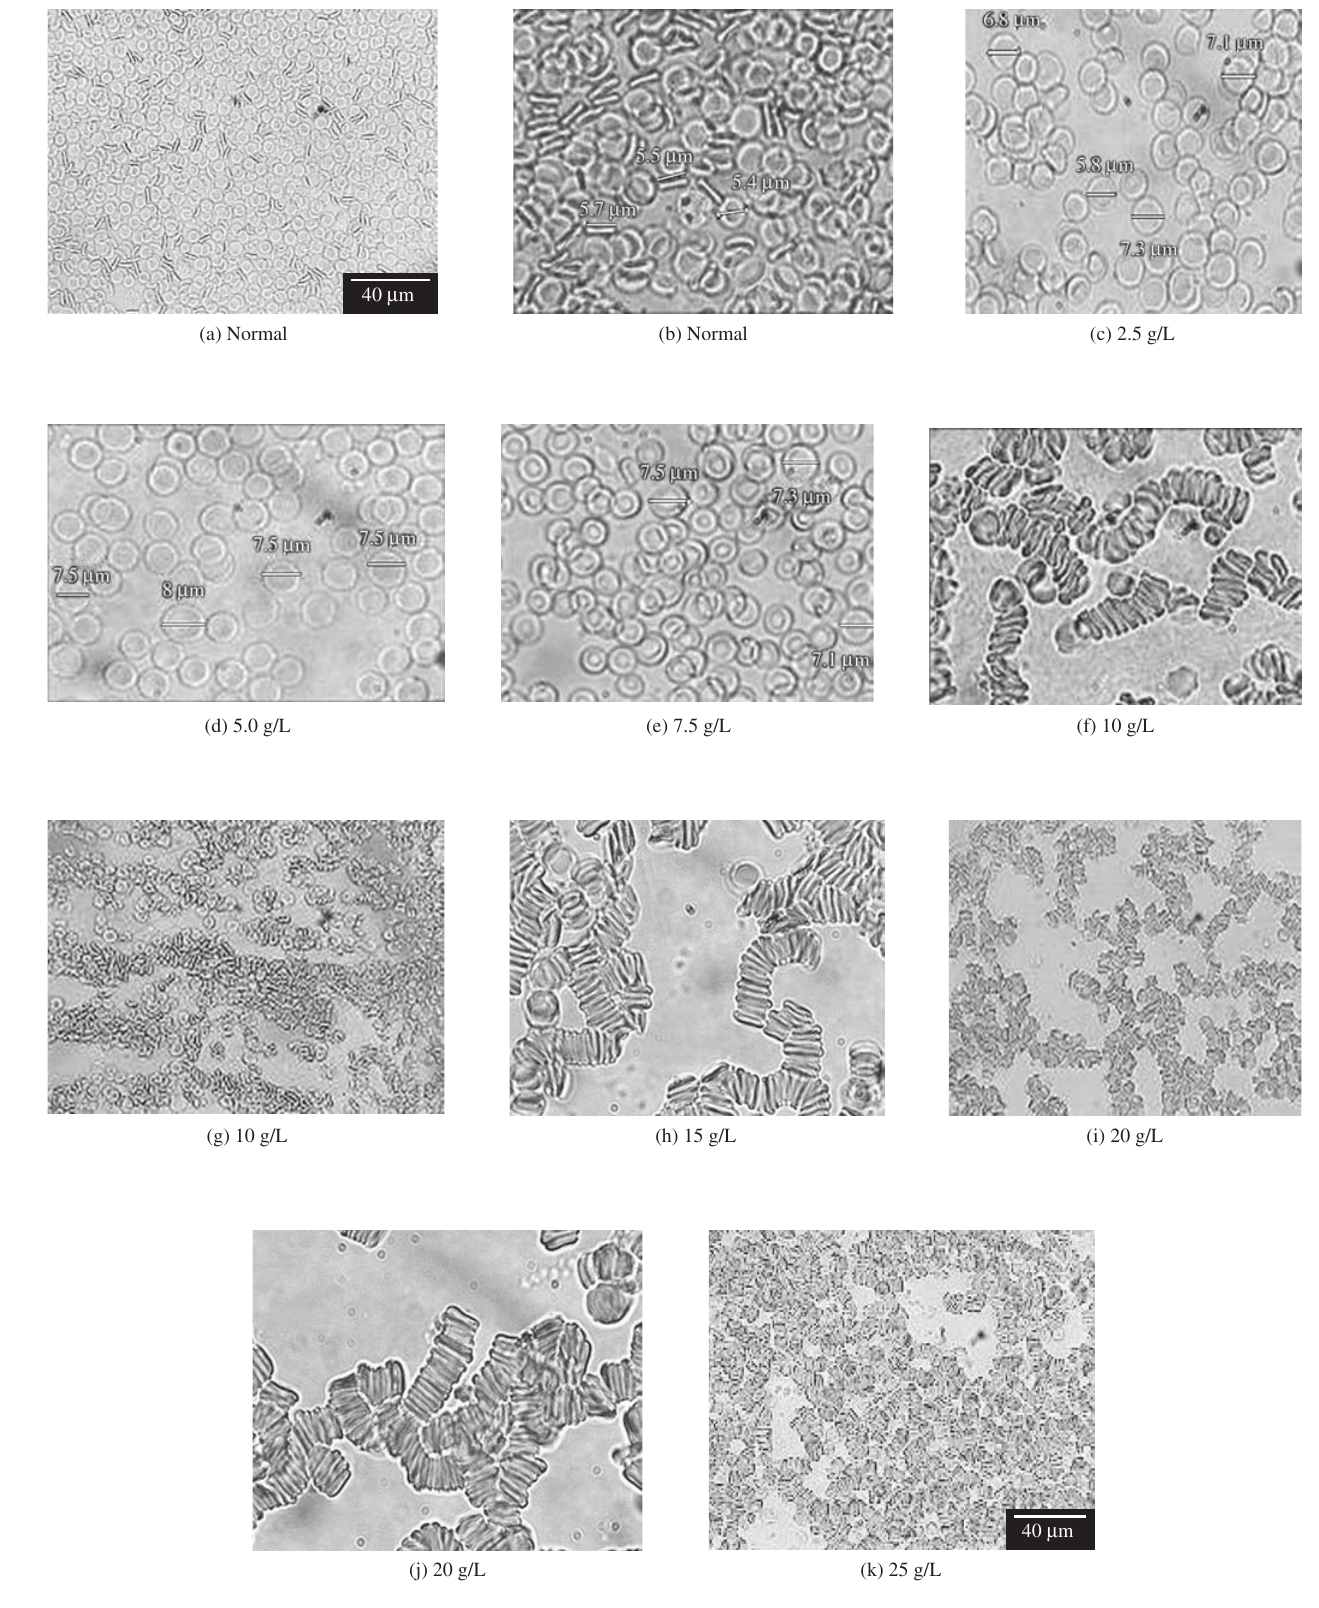
Figure 6. a,b) Microstructure of bovine blood; c) Microstructure of bovine blood containing 2.5 g/L of bovine fibrinogen; d) 5.0 g/L; e) 7.5 g/L; f,g) 10.0 g/L; h) 15 g/L; i,j) 20 g/L; and k) 25